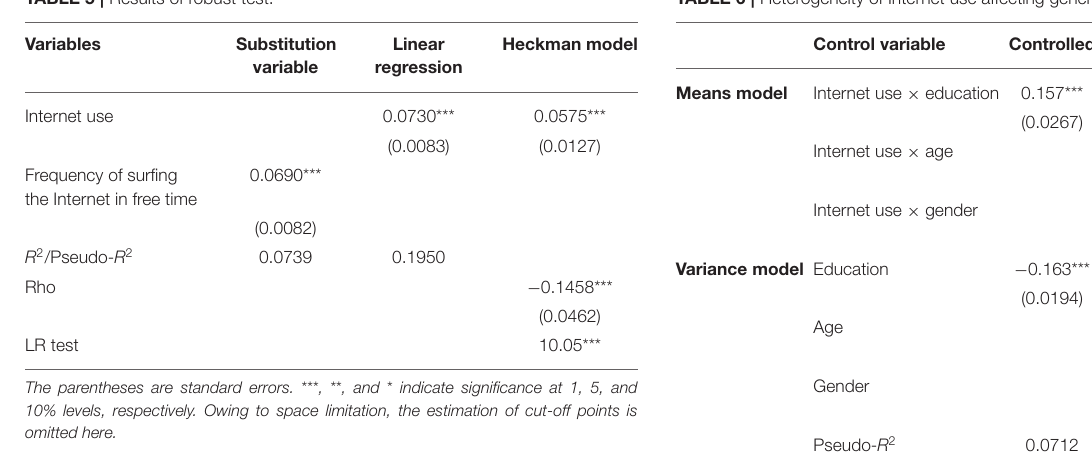
TABLE 5 | Results of robust test. TABLE 6 | Heterogeneity of Internet use affecting general